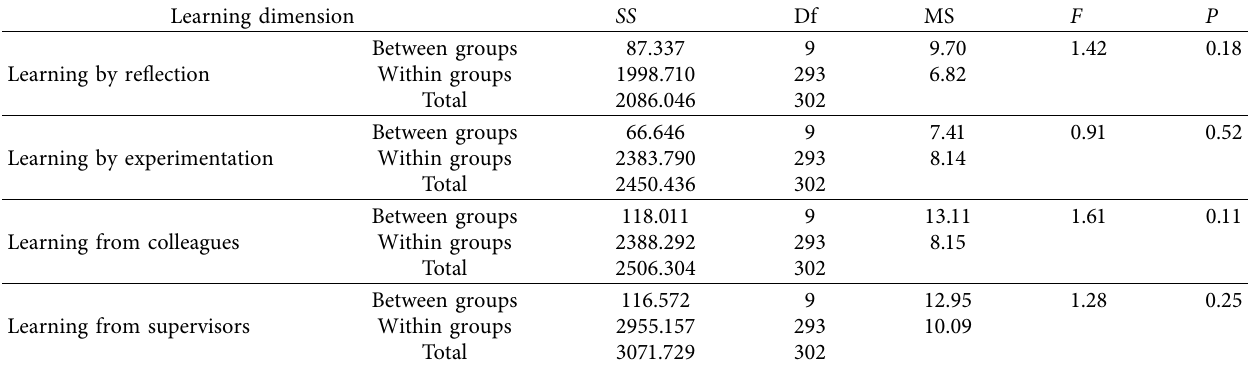
Table 4: ANOVA table shows a comparison result of the